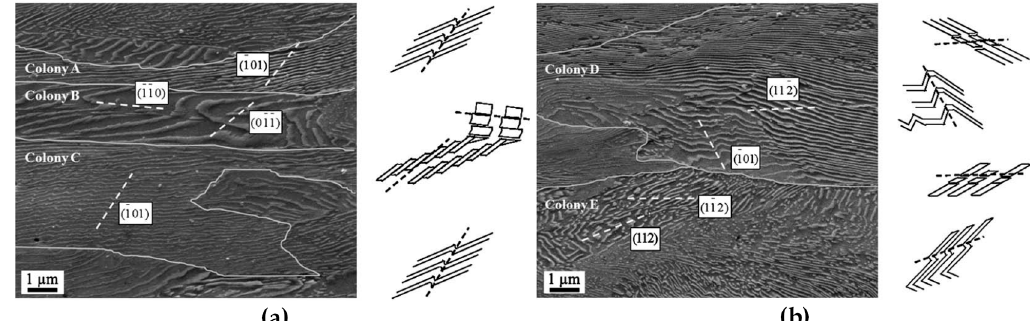
Figure 23. SEM micrographs showing the slip transfer of pearlite by fracture or bending of cementite lamellae. ( a ) {110} slip transfers; ( b ) {112} slip transfers. (Reprinted from Reference [10], with permission from Elsevier).